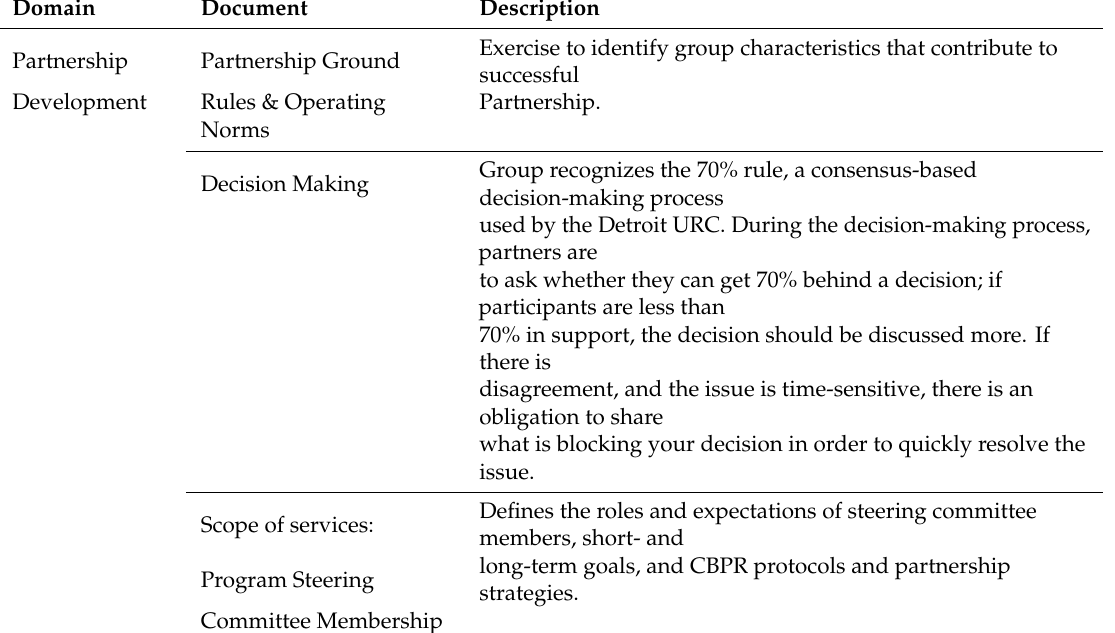
Table A2. HHH partnership development working